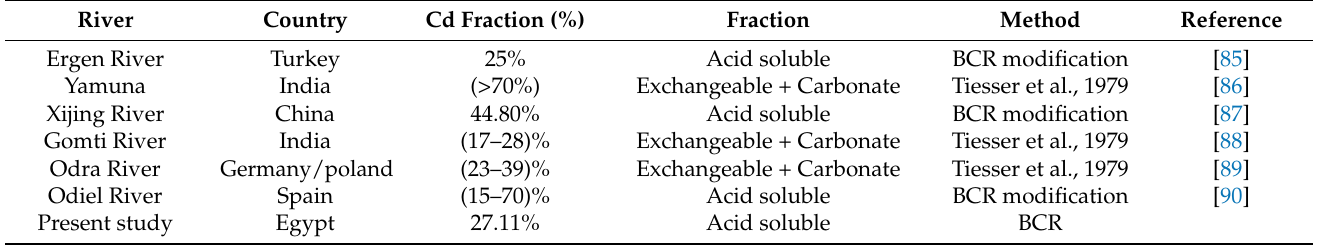
Figure 7. Treemap of cadmium metal potential Risk assessment Code (RAC) from all study positions to Nile River mainstream sediments. Table 4. Correlation between the bioavailability fraction of Cd (F1 %) in this study with Worldwide